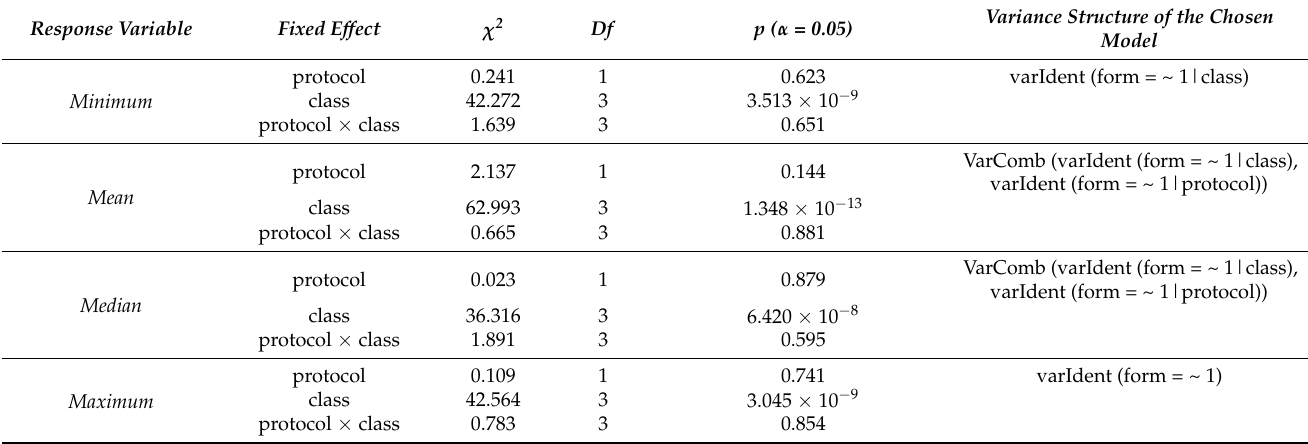
with the lowest AIC value) is also reported.